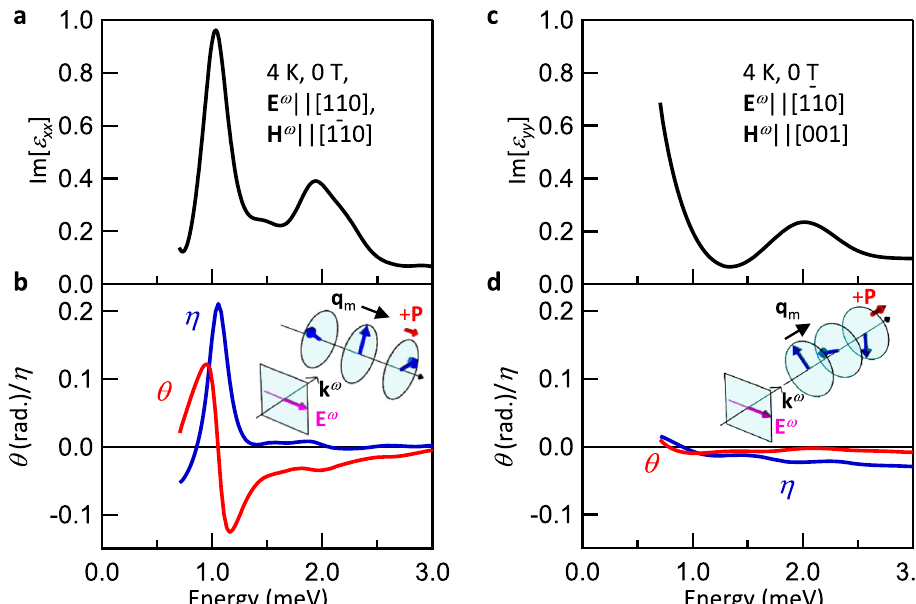
Fig. 4 Polarization selection rule for NOA. a The spectrum of electromagnon ( ε xx ) obtained for (001) surface at 0 T in the screw spin phase. Experimental con fi guration (inset to ( b )) is the same as that in Figs. 1, 2, and 3. b The rotation angle θ and ellipticity η at 0 T. The GB ( ε S xy ) is forbidden (see Fig. 2f) and the NOA ( ε A xy ) solely induces the optical rotation. c The spectrum for ε yy ( y ||[1 (cid:1) 10]) was obtained by using different samples with (110) surface at 0 T. The light polarization plane is perpendicular to P ||[110] (inset to ( d )). The observed spectrum is similar to ε yy obtained by using (001) surface (Fig. 2a). d The rotation angle θ and ellipticity η for (110)